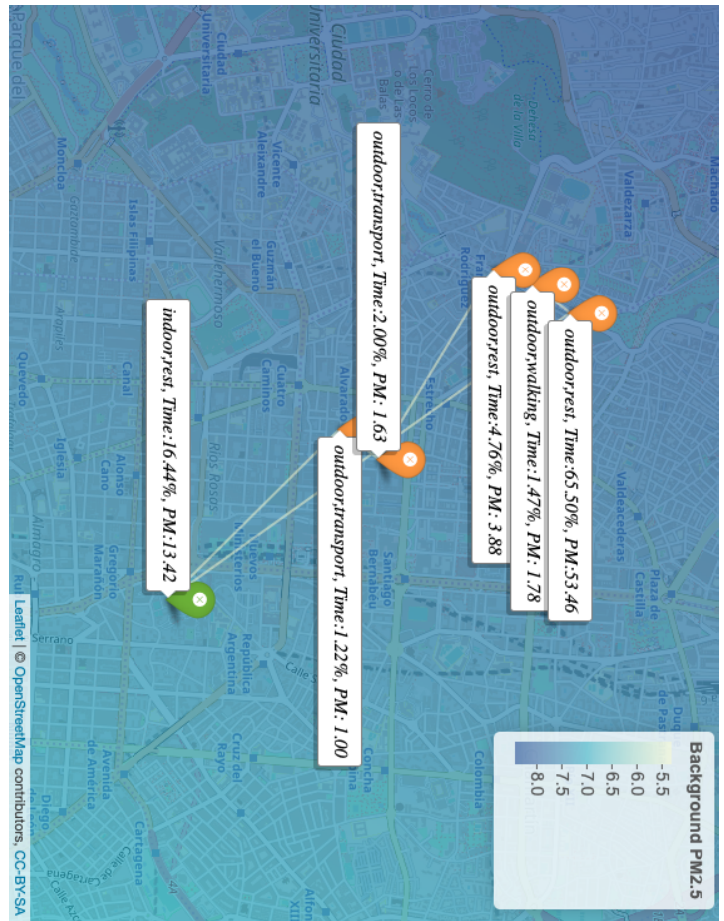
Figure 6. One Day PM 2.5 Exposure Per Location, Activity Type, and Time